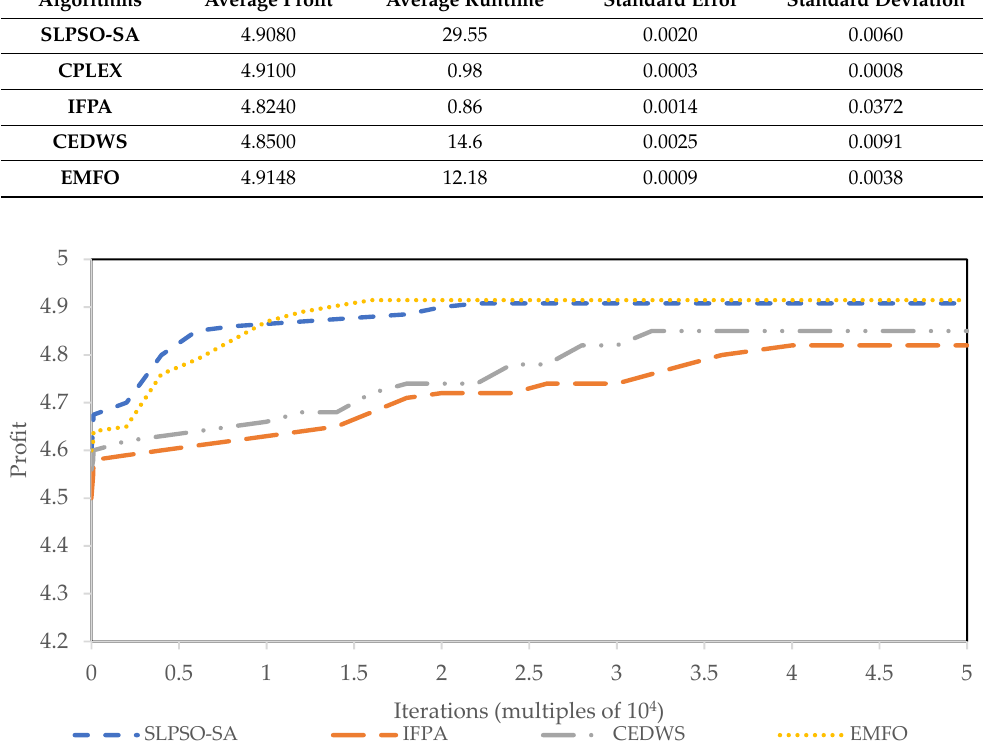
Table 7. Comparison of simulation results of instance type 1.